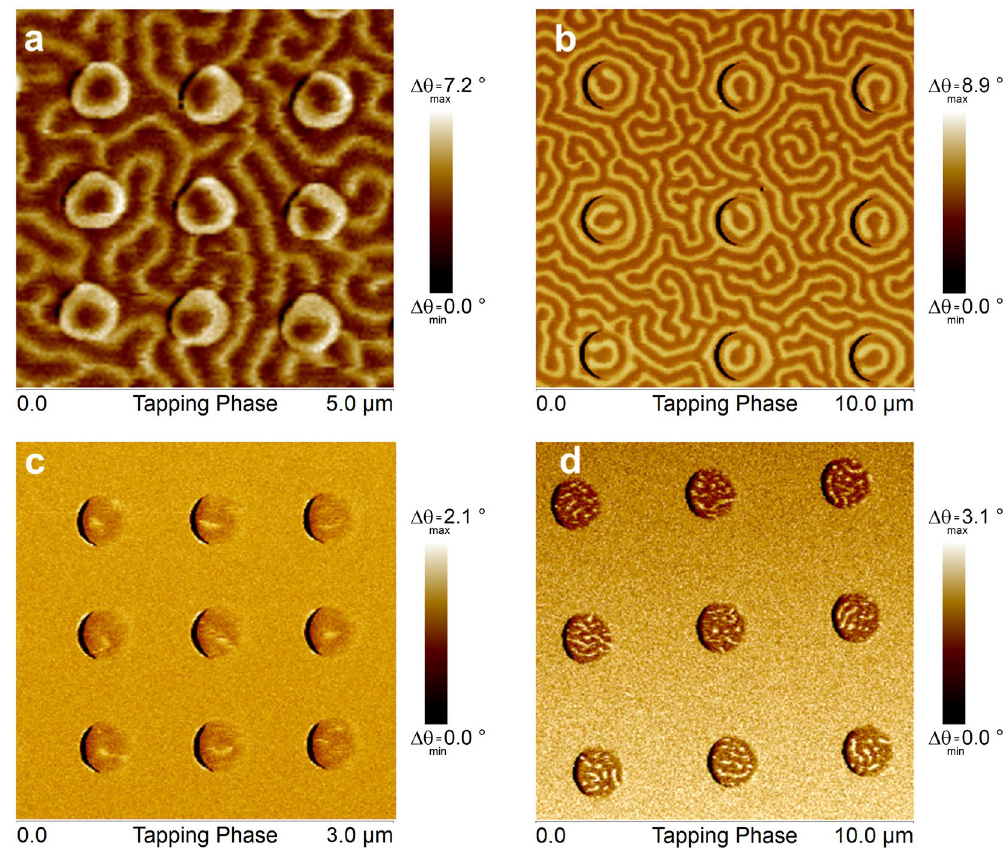
Figure 4. MFM images of disk arrays for 15PP-A ( a , b ) and 15FP-AI ( c , d ) samples taken under no external field after in-plane AC demagnetization with 1 T maximum field and application of 3 T perpendicular-to-plane field. MFM images belong to arrays of disks with diameters ( a ) 500 nm, ( c ) 300 nm, ( b ) and ( d ) 1200